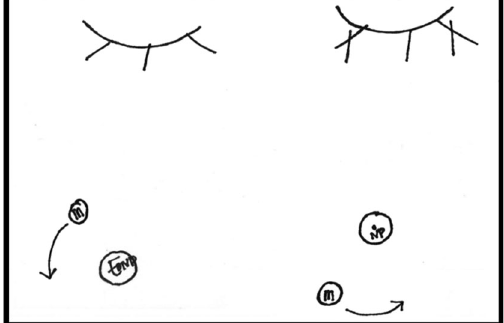
FIG. 7. Left-hand side: Olivia ’ s Earth-Moon-Sun geometrical configuration for a waxing crescent Moon phase. Right hand side: Olivia ’ s Earth-Moon-Sun geometrical configuration for waxing gibbous Moon phase. Moon (M); Earth (E), and North Pole (NP).